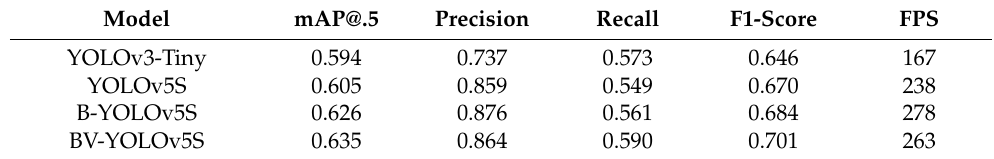
Table 2. Test results of different defect detection models in the pavement defect dataset. (Through independent test set testing, the precision, recall, and F1-score values of each category were provided and averaged). Model mAP@.5 Precision Recall F1-Score FPS YOLOv3-Tiny 0.594 0.737 0.573 0.646 167 YOLOv5S 0.605 0.859 0.549 0.670 238 B-YOLOv5S 278 BV-YOLOv5S